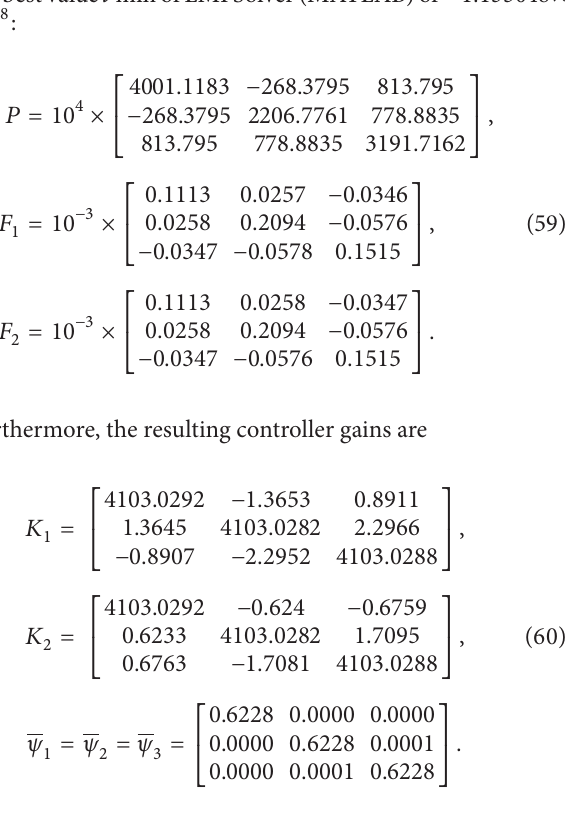
̇𝑋(𝑡) for original system and NN model. (b) The responses of